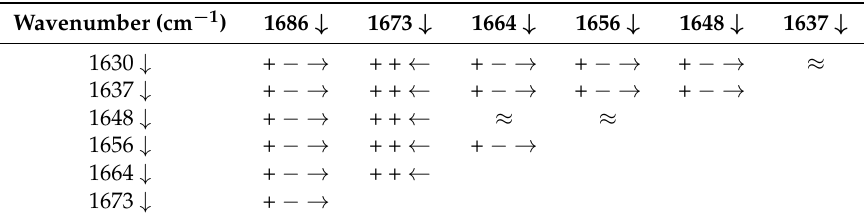
Table 5. Correlation table for deconvolved FTIR spectra of PSCs (5% w / v in D 2 O) upon heating (5 → 70 °C, in increment of 5 °C) and the sequence of structural changing events. Wavenumber (cm − 1 ) 1686 ↓ 1673 ↓ 1664 ↓ 1656 ↓ 1648 ↓ 1637 ↓ 1630 ↓ ≈ 1656 ↓ + − → + + ← + − → 1637 ↓ 1664 ↓ + − → + + ← 1648 ↓ ≈ ≈ 1673 ↓ + − → Column and row headings represent the x and y wavenumbers, respectively, from the 2D maps in Figure 7. Vertical arrows represent an increase ( ↑ ) or decrease ( ↓ ) in the band intensity as the temperature increased, as deduced from 1D spectra. The signs “+” and “–“ indicated positive and negative peaks in the 2D synchronous map and asynchronous map, respectively. The sign “ ≈ ” indicated there is no correlation peak is found in the asynchronous map which means both peaks change at the same time. Horizontal arrows indicate that the intensity change at y·cm − 1 occurs before ( → ) or after ( ← ) that at x·cm − 1 .